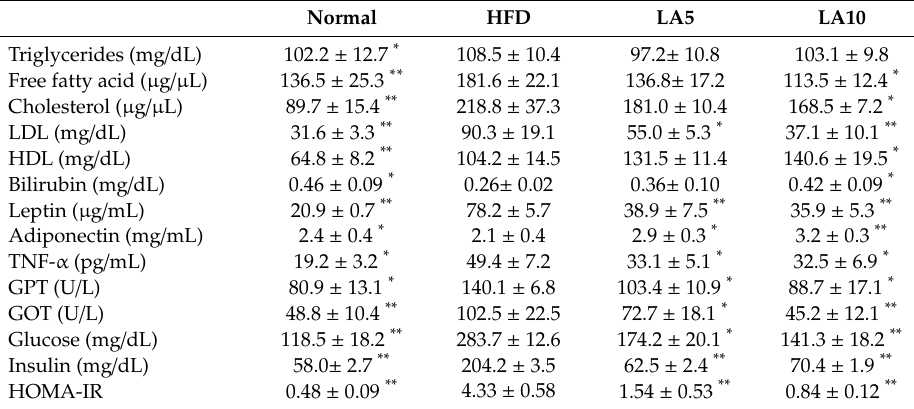
Figure 3. Licochalcone A (LA) ameliorated hepatic steatosis in HFD-induced obese mice. ( A ) The appearance of the liver, ( B ) liver weight, and ( C ) HE staining of liver tissues (200 × magnification). ( D ) The calculated number of lipid droplets in liver tissue. ( E ) PAS staining demonstrating the glycogen distribution in the liver (200 × magnification). ( F ) TG and ( G ) TC levels in the liver. ( H ) NAFLD scores based on the evaluation of HE staining of liver tissues. Data are presented as the mean ± SEM; n = 12. * p < 0.05, ** p < 0.01 compared with mice with HFD-induced obesity. Table 2. Serum biochemical